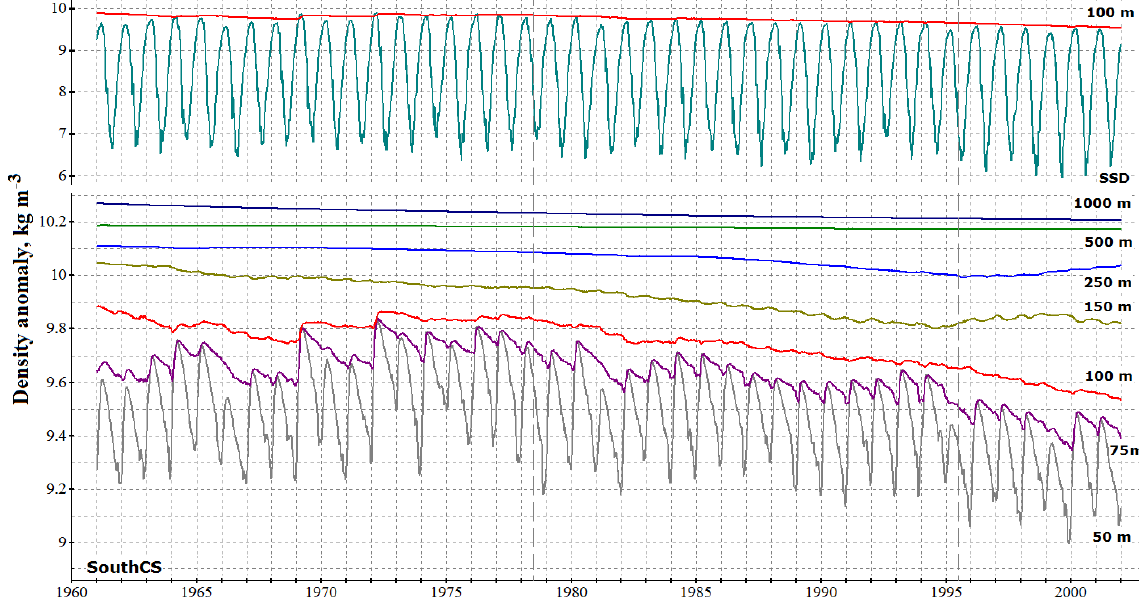
Figure 14. Evolution of a density anomaly (kgm − 3 ) at different depths (SSD – sea surface density) averaged over the SouthCS